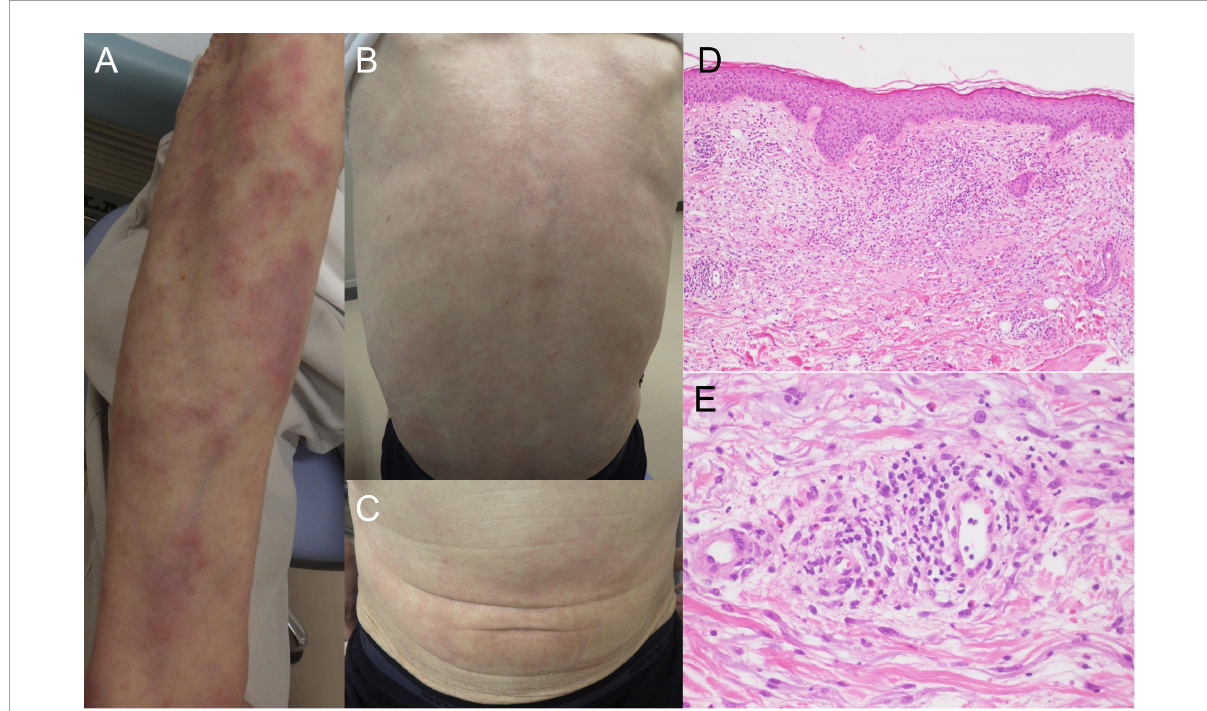
FIGURE1 Clinical manifestations and histopathology. (A) Multiple erythematous plaques and nodular lesion on the upper limbs. (B) Urticarial lesions on the back. (C) Erythematous lesions on the abdomen. (D) Infiltration of inflammatory cells from the upper dermis to the subcutaneous fat (hematoxylin-eosin stain, original magnification × 100). (E) High magnification of dermal infiltrates around the perivascular region. The inflammatory infiltrates contain neutrophils, histiocytes, lymphoid cells, and eosinophils (hematoxylin-eosin stain, original magnification ×